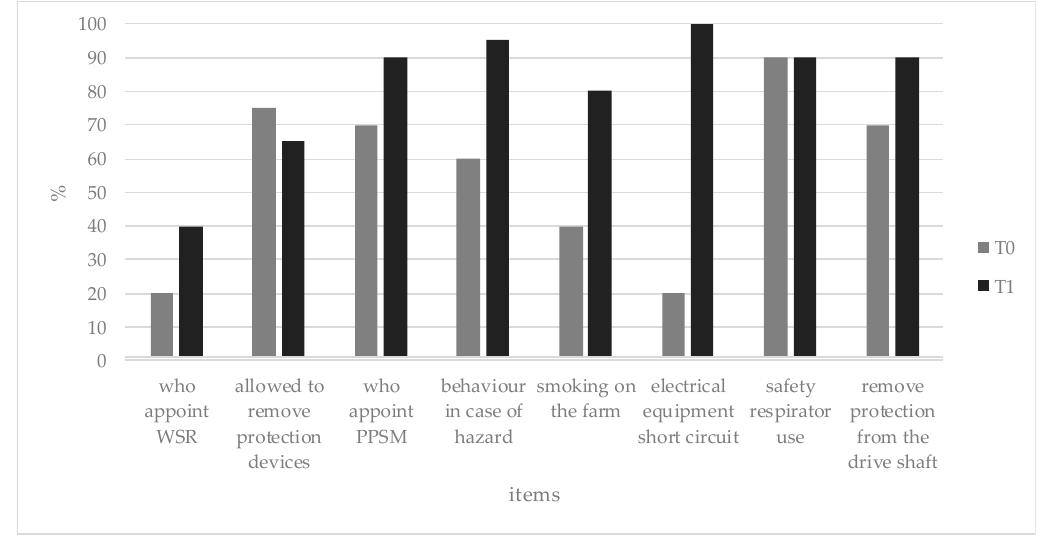
Figure 5. Percentage of correct answers provided by participants at T0 and T1 for each item.